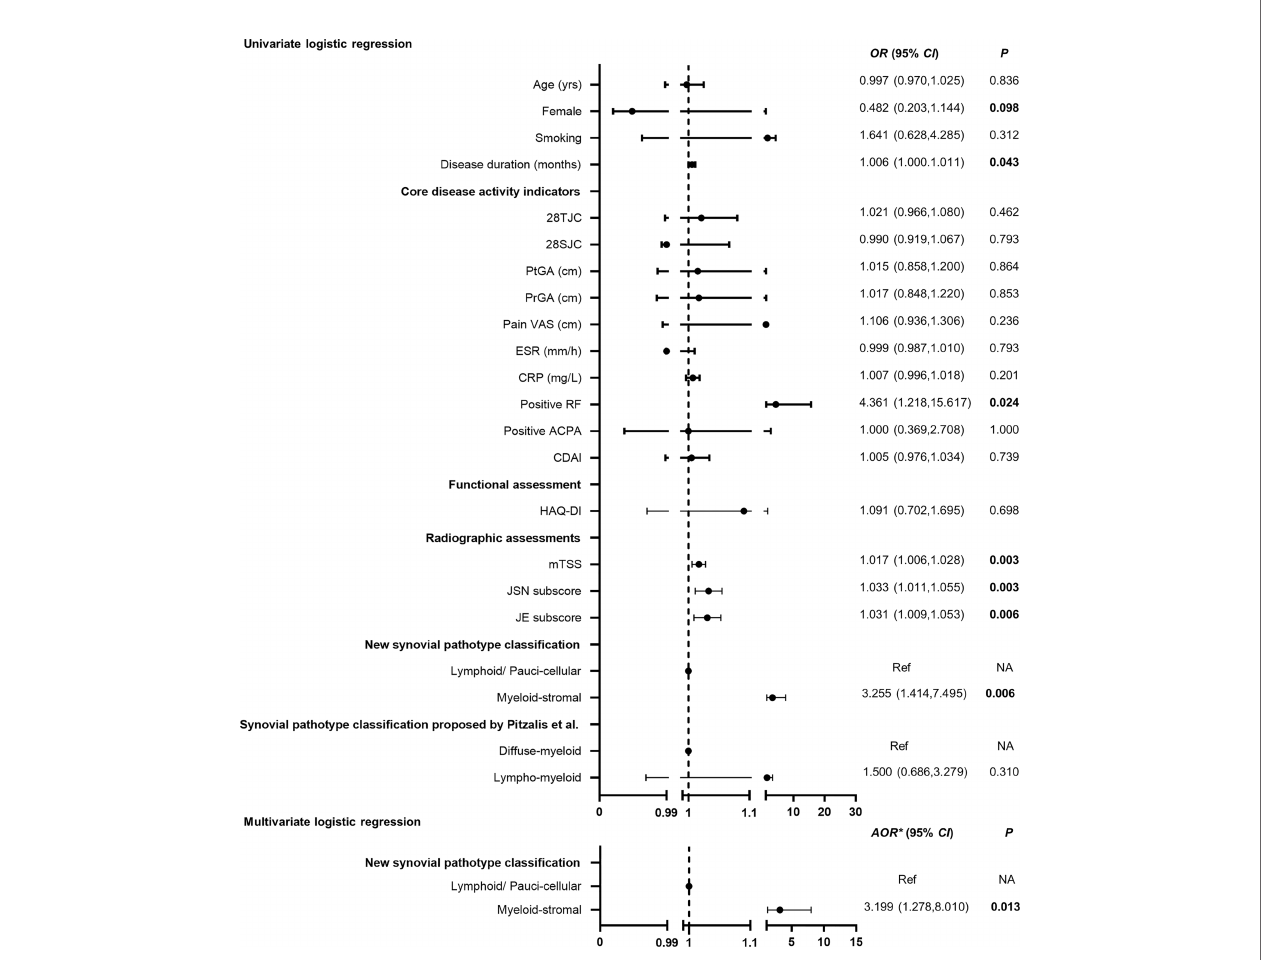
FIGURE 4 | Performance of baseline myeloid-stromal pathotype as a predictor for 1-year radiographic progression. OR, odds ratio; 95% CI, 95% con fi dence interval; Ref, reference. AOR * adjusted for variables with p < 0.1 in the univariate analysis (sex, disease duration, RF status, mTSS) at baseline. NA, data not